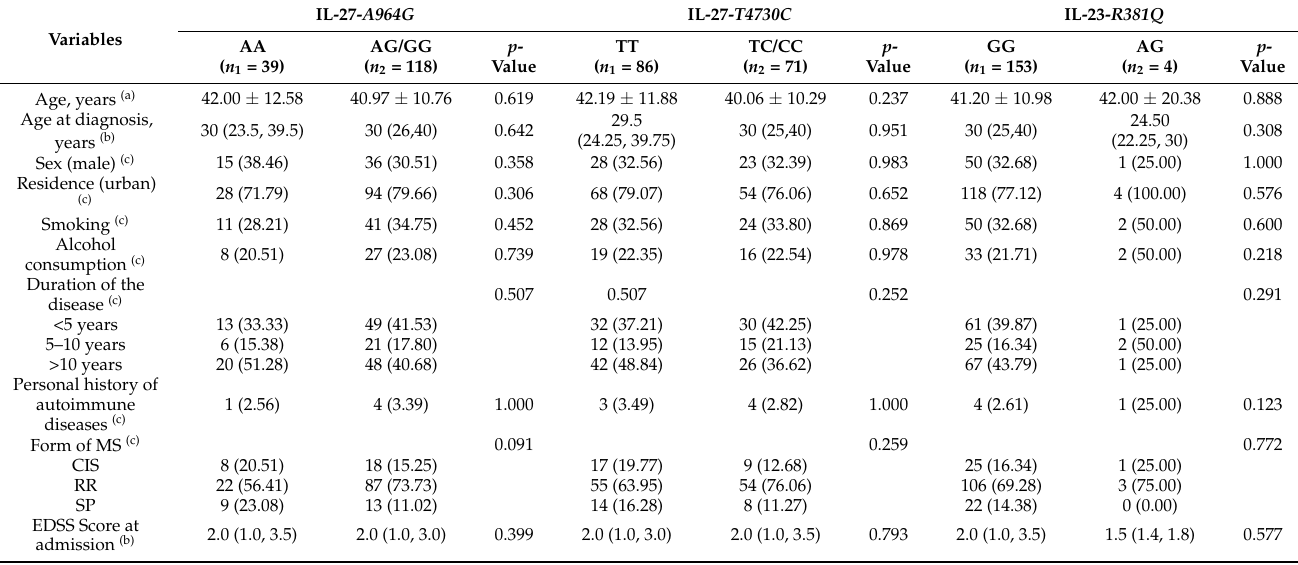
Table 6. Association between IL-27- T4730C , IL-27- A964G , IL-23- R381Q and clinical characteristics of multiple